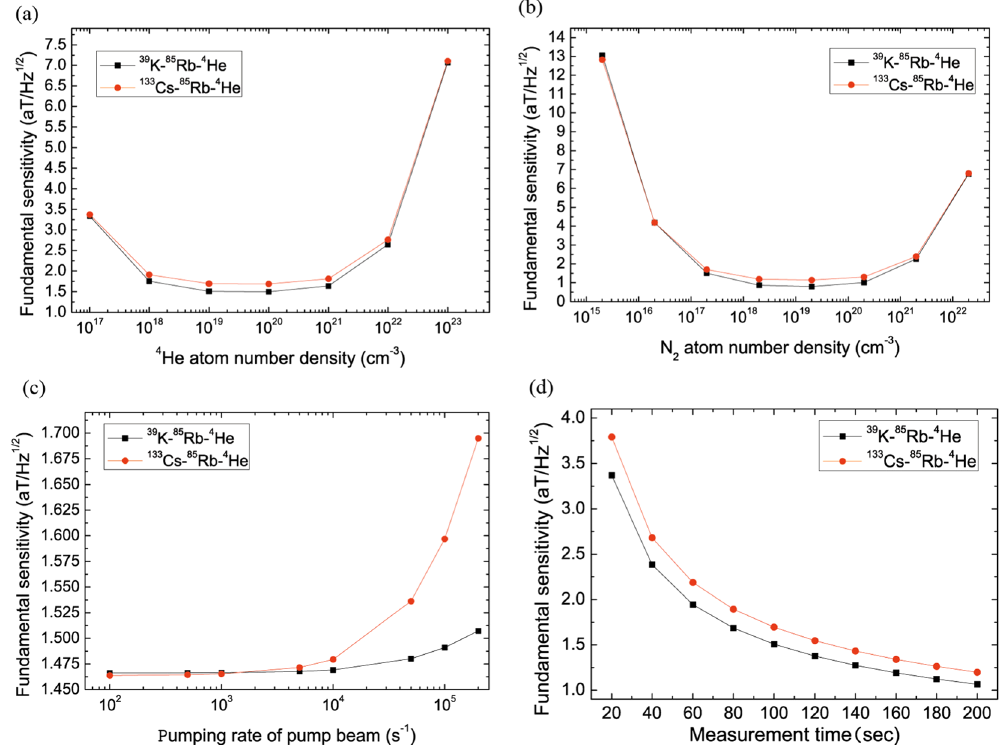
Figure 4. The fundamental sensitivity of 39 K ( 133 Cs)- 85 Rb- 4 He magnetometers varies with the number density of buffer gas 4 He and quench gas N 2 , pumping rate of pump beam, measurement time. ( a ) The fundamental sensitivity of 39 K- 85 Rb- 4 He magnetometer (black line in squares) increases with the increasing number density of 4 He when 4 He number density is smaller than a critical value about 4.22 × 10 19 cm − 3 and decreases when 4 He number density is bigger than the value. The fundamental sensitivity of 133 Cs- 85 Rb- 4 He magnetometer (red line in dots) increases with the increasing number density of 4 He when 4 He number density is smaller than a critical value about 4.15 × 10 19 cm − 3 and decreases when 4 He number density is bigger than the value. ( b ) The fundamental sensitivity of 39 K- 85 Rb- 4 He magnetometer (black line in squares) increases with the increasing N 2 number density when N 2 number density is smaller than a critical value about 1.22 × 10 19 cm − 3 and decreases when N 2 number density is higher than the value. The fundamental sensitivity of 133 Cs- 85 Rb- 4 He magnetometer(red line in dots) increases with the increasing N 2 number density when N 2 number density is smaller than a critical value about 1.21 × 10 19 cm − 3 and decreases when N 2 number density is higher than the value. The fundamental sensitivity of 39 K ( 133 Cs)- 85 Rb- 4 He magnetometers decrease with the increasing pumping rate of pump beam in ( c ). The fundamental sensitivity of 39 K ( 133 Cs)- 85 Rb- 4 He magnetometers increase with the increasing measurement time. The fundamental sensitivity of 133 Cs- 85 Rb- 4 He magnetometer is lower than the one of 39 K- 85 Rb- 4 He magnetometer in ( d